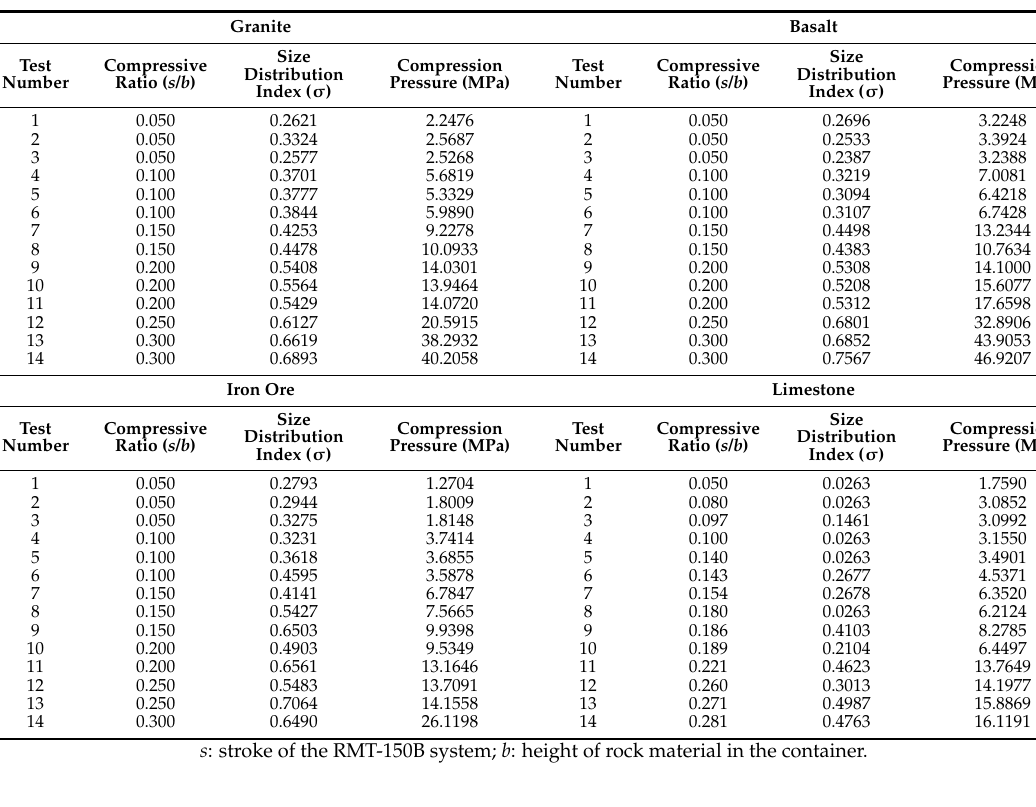
Table 1. Results of crushing experiments.